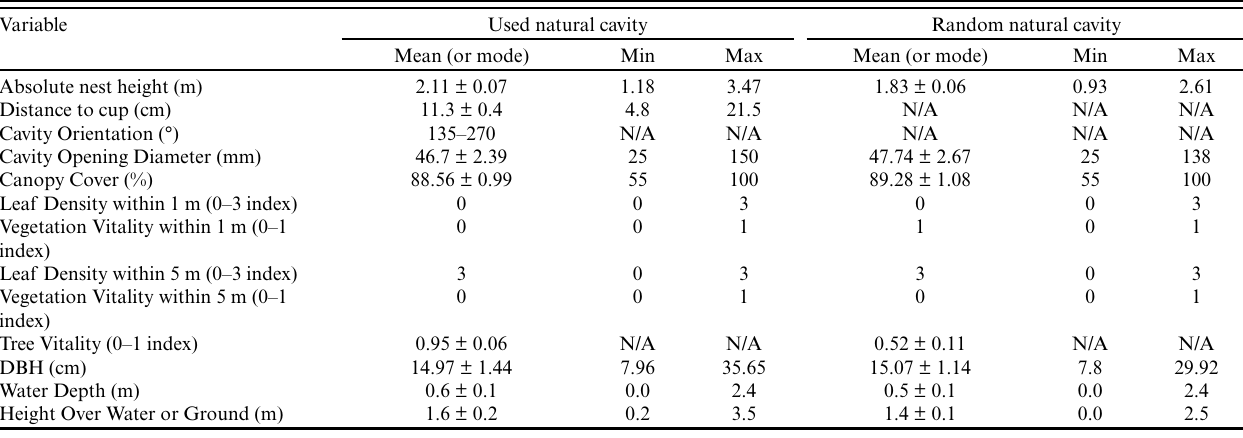
Table 3 . Summary of all microhabitat variables measured for Prothonotary Warbler ( Protonotaria citrea ) natural cavity nests found in White River National Wildlife Refuge, Arkansas, USA in 2014–2015. We also present data for random, available cavities measured for habitat selection analysis. Leaf density and vegetation vitality measurements were visually estimated on relative indexes of 0 (low) to 3 (high) and 0 (alive) to 1 (dead), respectively, so we present modes instead of means. Tree vitality was binomial (0 = alive, 1 = dead) and therefore we provide no minimum or maximum value. For Cavity Orientation, we also present the mode. All means are presented ± 1 SE. Used natural cavity Random natural cavity